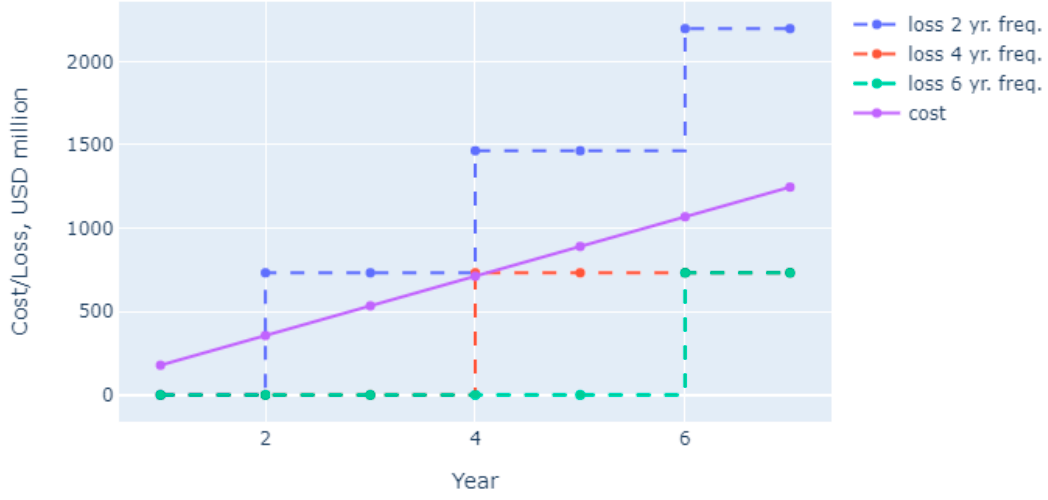
Figure 2. Value of mortality risk (VMR) example: Air Cargo Screening analysis.